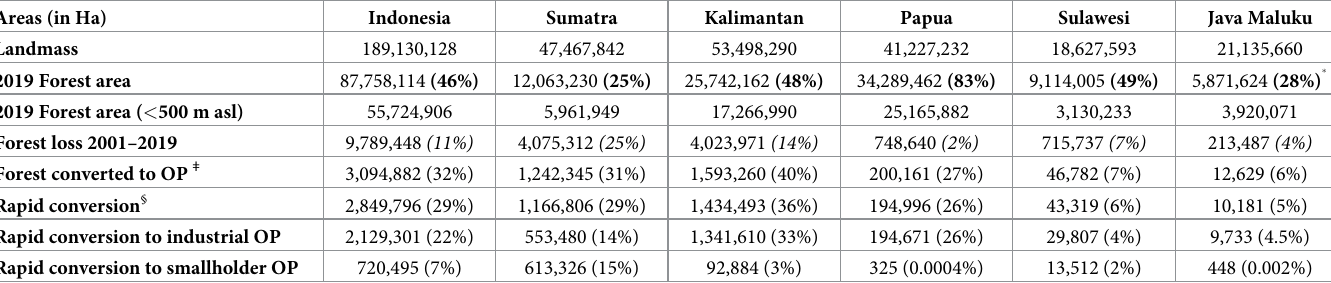
Table 1. Share of deforestation caused by oil palm expansion from 2001 to 2019 for Indonesia and by region. Areas (in